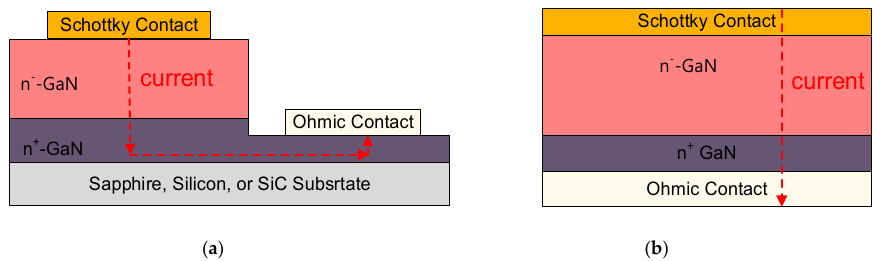
Figure 1. Gallium nitride Schottky barrier diode (GaN SBD) structure and current flowing directions: ( a ) quasi-vertical and ( b ) fully-vertical.